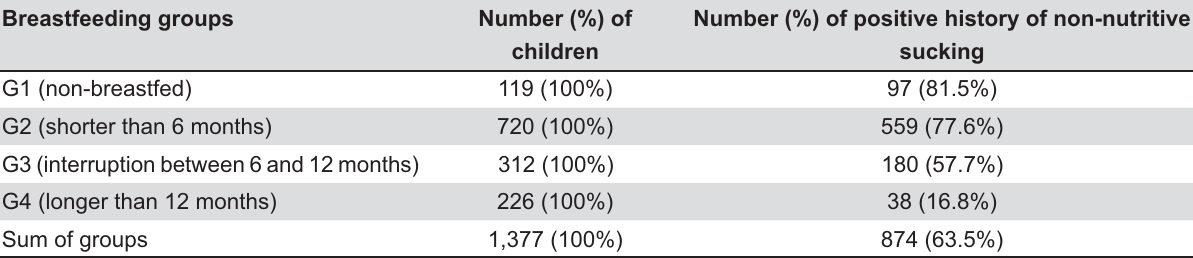
Table 4- Distribution of children with positive history of non-nutritive sucking habits according to breastfeeding Breastfeeding groups